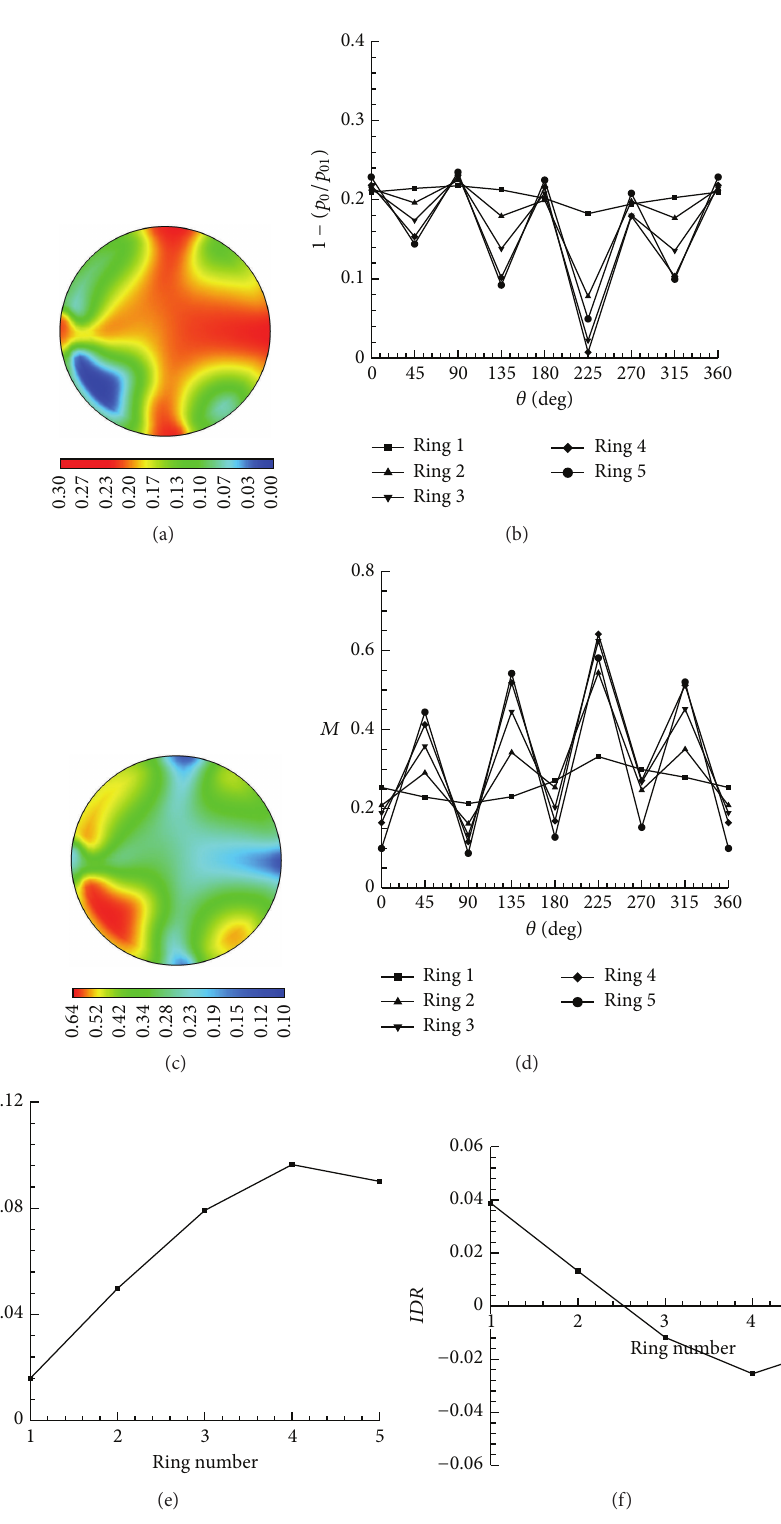
Figure 6: Distortion parameters at the AIP for four jets with unequal mass flow rates 𝑚 2 /𝑚 4 = 0.214 (𝐷𝐼 = 27.495 % ) . In this figure (a) contours of total pressure loss [1 − (𝑝 0 /𝑝 01 ) ], (b) distribution of total pressure loss in each of the five rings, (c) contours of Mach number, (d) Mach number distribution in the five rings, (e) the circumferential distortion parameter IDC, and (f) the radial distortion parameter IDR in the